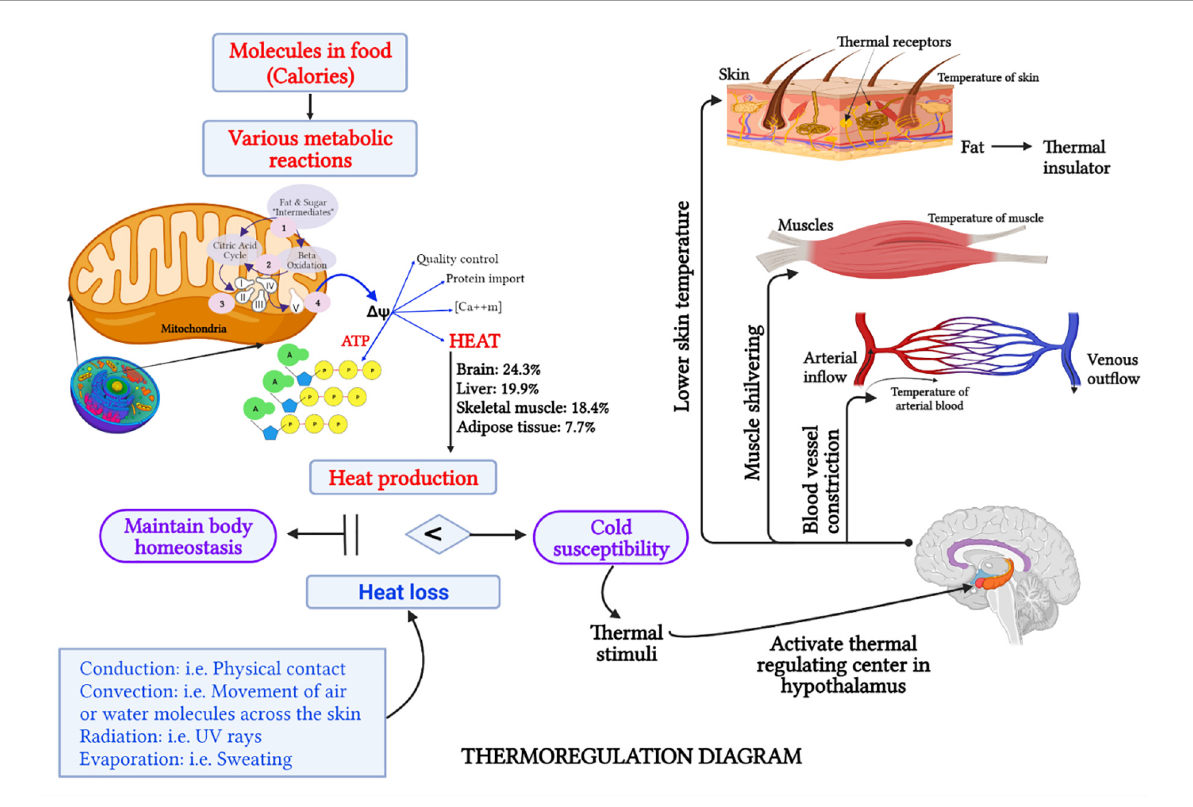
FIGURE1 Schematic representation (created with BioRender.com) of the thermoregulation mechanism in the human body. Intracellular mitochondria play a critical role in generating energy (in the form of ATP) and heat, which is sufficient for a cell’s sustenance (52). Healthy cellular mitochondria in the brain, liver, and skeletal muscle mass contribute as much as 63% of the body heat (58). When heat production and heat loss are balanced, human body homeostasis is maintained. However, when heat production is insufficient to compensate heat loss, which occurs via conduction, convection, radiation, or evaporation, the human body is likely to be susceptible to cold (85, 86). For a given thermal stimuli, such as cold wind, the thermoreceptors which are free nerve endings in the skin and other organs will send a signal to the hypothalamus to activate the heat-regulating center (87). Consequently, several responses, such as lowering of skin temperature, shivering of skeletal muscle to produce more heat, and vasoconstriction to prevent heat loss, will take place (35). Therefore, individuals with CP usually experience cold sensations in their hands or feet, have a pale face, and seek a warmer